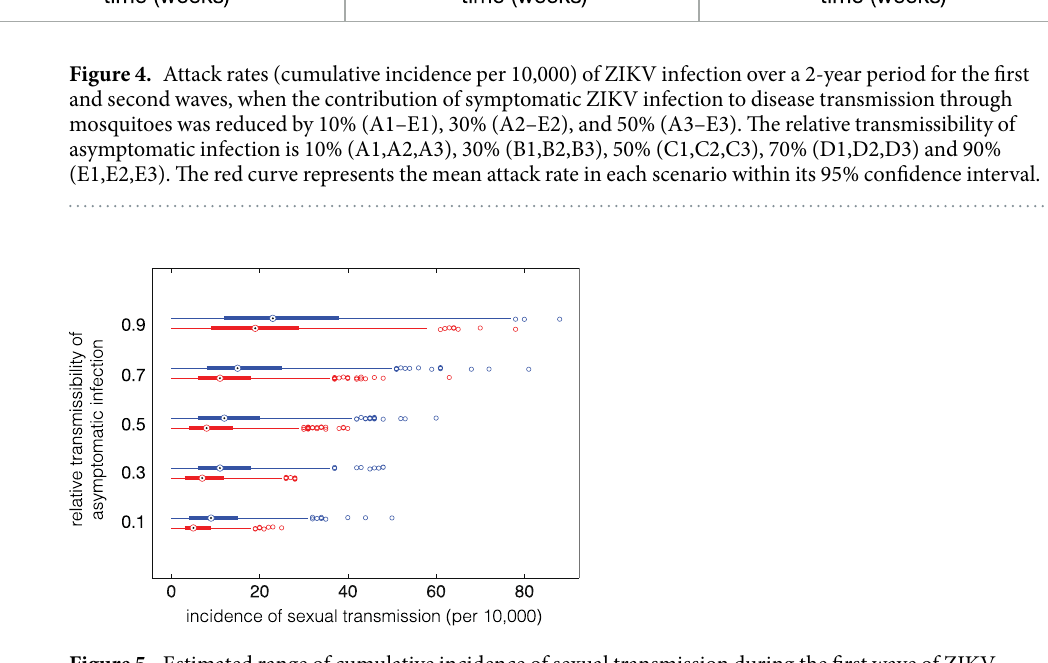
Figure 5. Estimated range of cumulative incidence of sexual transmission during the first wave of ZIKV infection as a function of the relative transmissibility of asymptomatic infection, in the absence of condom use (blue) and 50% condom use during symptomatic infection